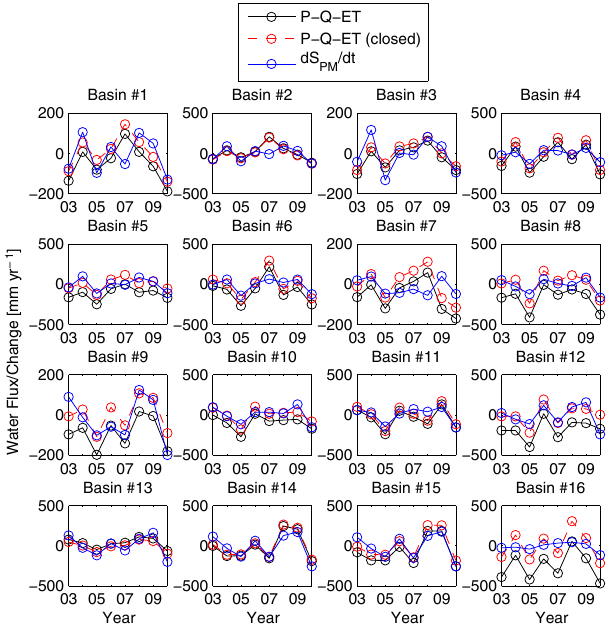
Figure 4. For the 16 medium-scale basins listed in Table 2, the an- nual time series of raw P − Q − E T (solid black line) and P − Q − E T obtained by assuming flux closure over the 8-year period of record (dashed red line). Values of the microwave-based d S PM / d t proxy are also plotted (solid blue line).